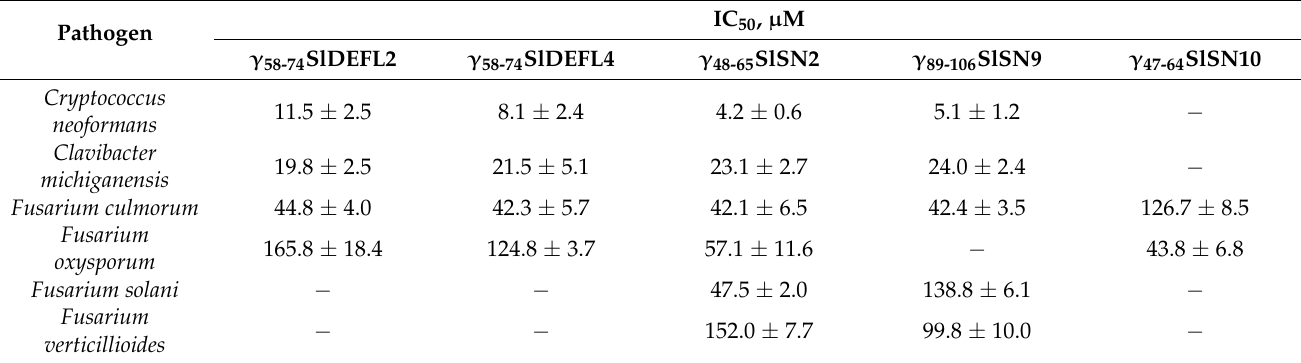
Table 2. Antimicrobial activity of synthetic peptides